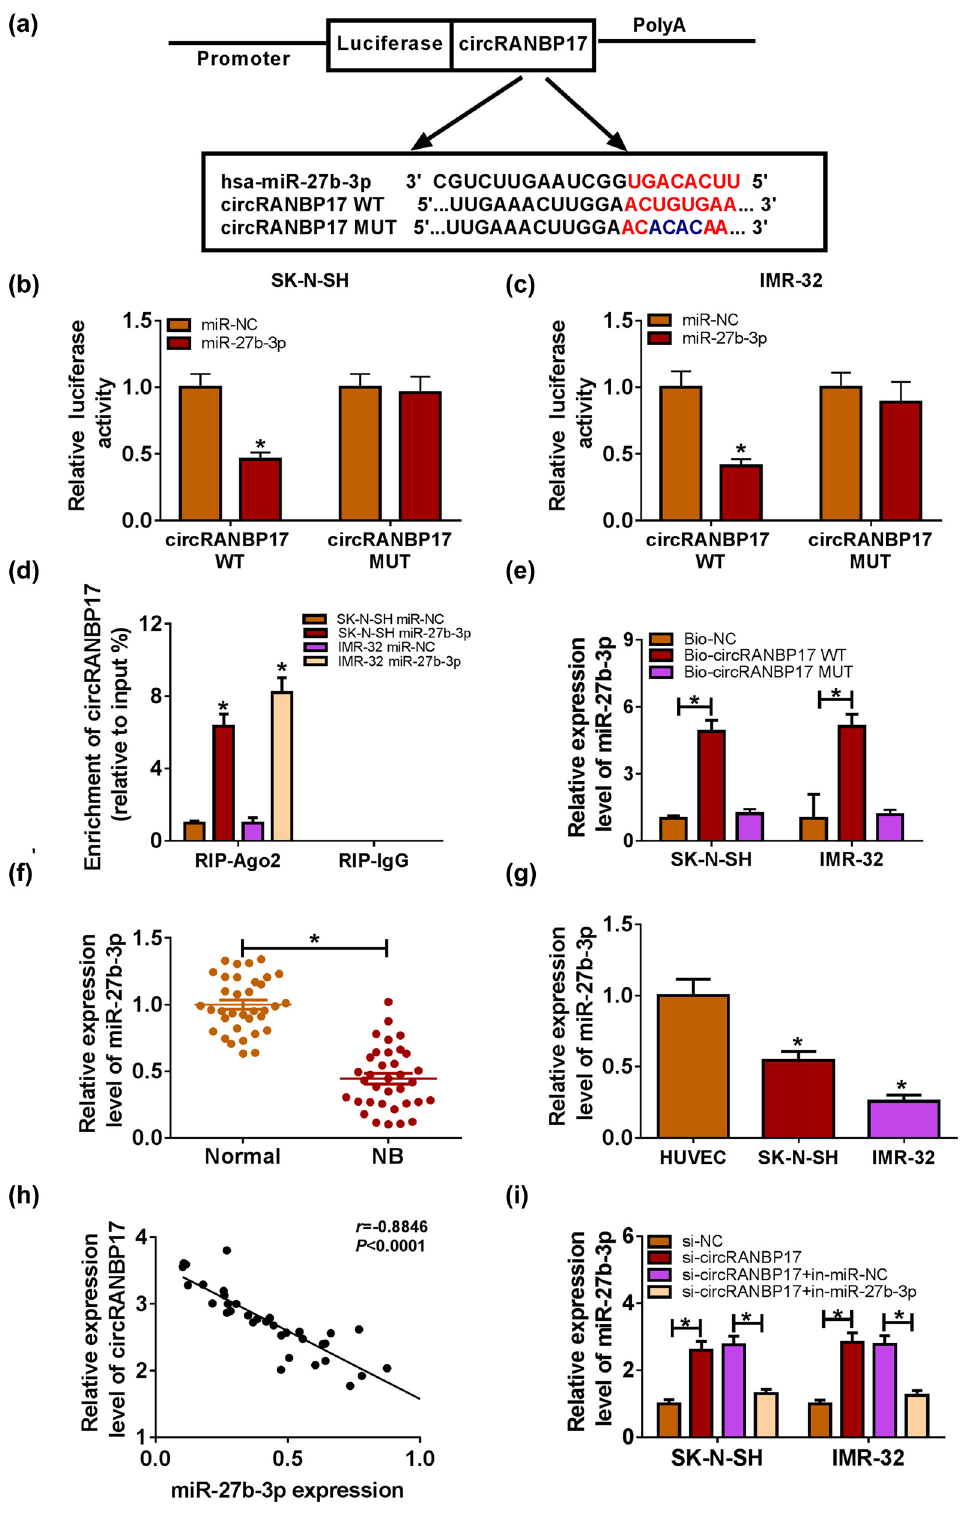
Figure 4: miR - 27b - 3p negatively interacts with circRANBP17. ( a ) Complementary binding sites between miR - 27b - 3p and circRANBP17. The interaction between miR - 27b - 3p and circRANBP17 was veri fi ed by dual luciferase reporter assay in SK - N - SH ( b ) and IMR - 32 ( c ) cells. ( d ) Enrichment of circRANBP17 by Ago2 or IgG antibody was performed by RIP assay. ( e ) RNA pull - down assay was carried out to con fi rm the association of miR - 27b - 3p and circRANBP17. The level of miR - 27b - 3p in NB tissues ( f ) and cells ( g ) was measured by qRT - PCR. ( h ) Correlation between miR - 27b - 3p and circRANBP17. ( i ) Level of miR - 27b - 3p in both the SK - N - SH and IMR - 32 cells transfected with si - NC, si - circRANBP17, si - circRANBP17 + in - miR - NC or si - circRANBP17 + in - miR - 27b - 3p. * P <